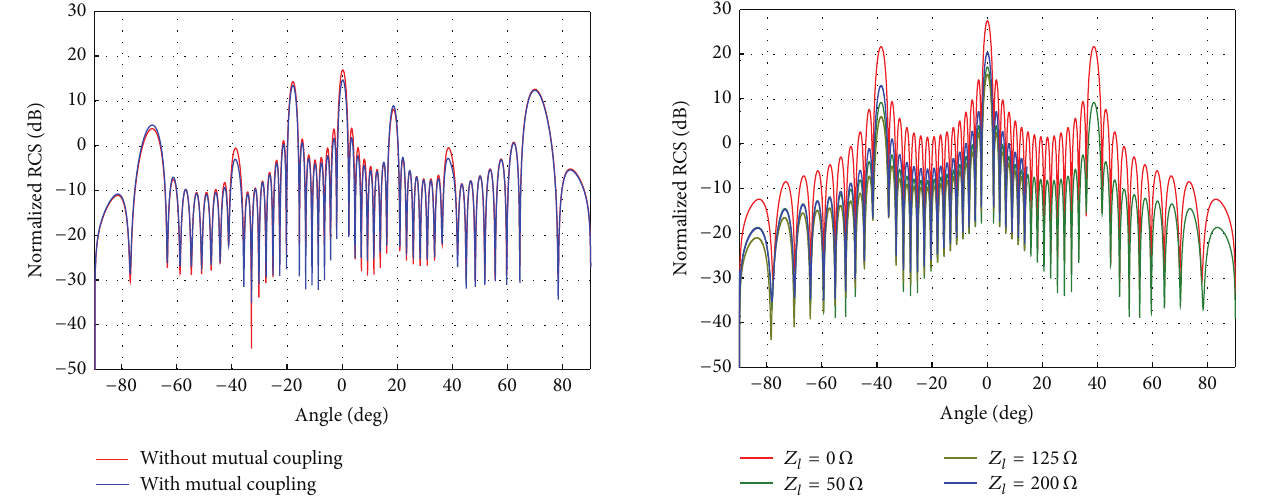
Figure 20: Effect of varying the impedance terminating the dif- ference port of the first-level couplers on the broadside RCS of a parallel-fed linear 32-element dipole